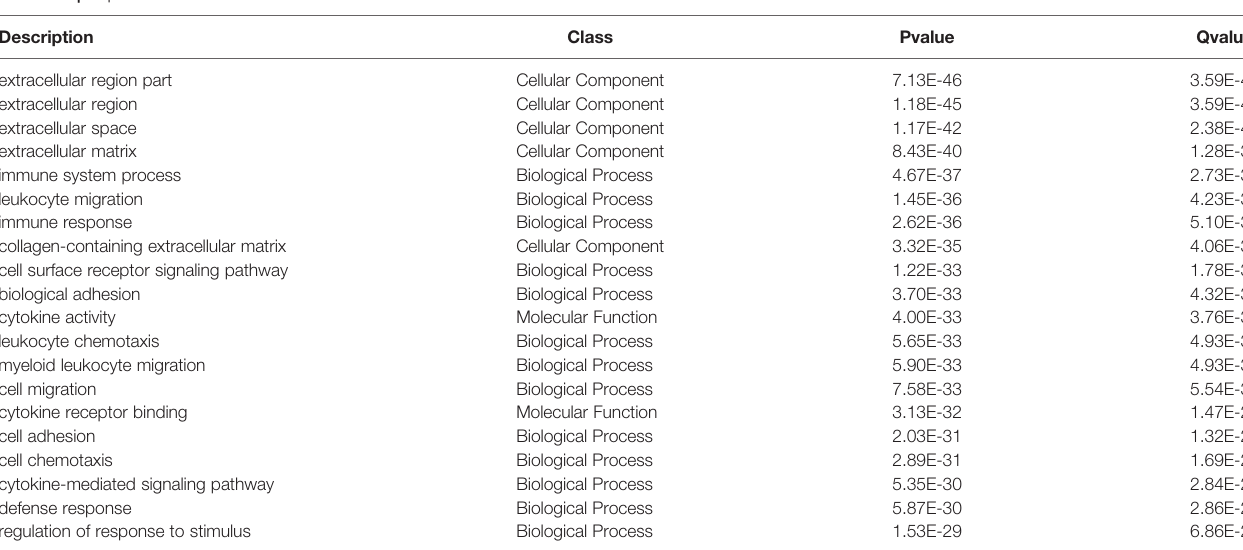
TABLE 1 | Top 20 GO